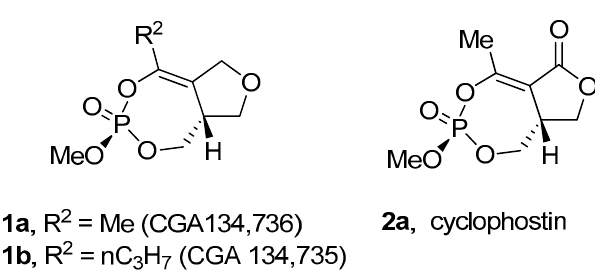
Figure 1. CGA 134,736, CGA 134,735 and cyclophostin.